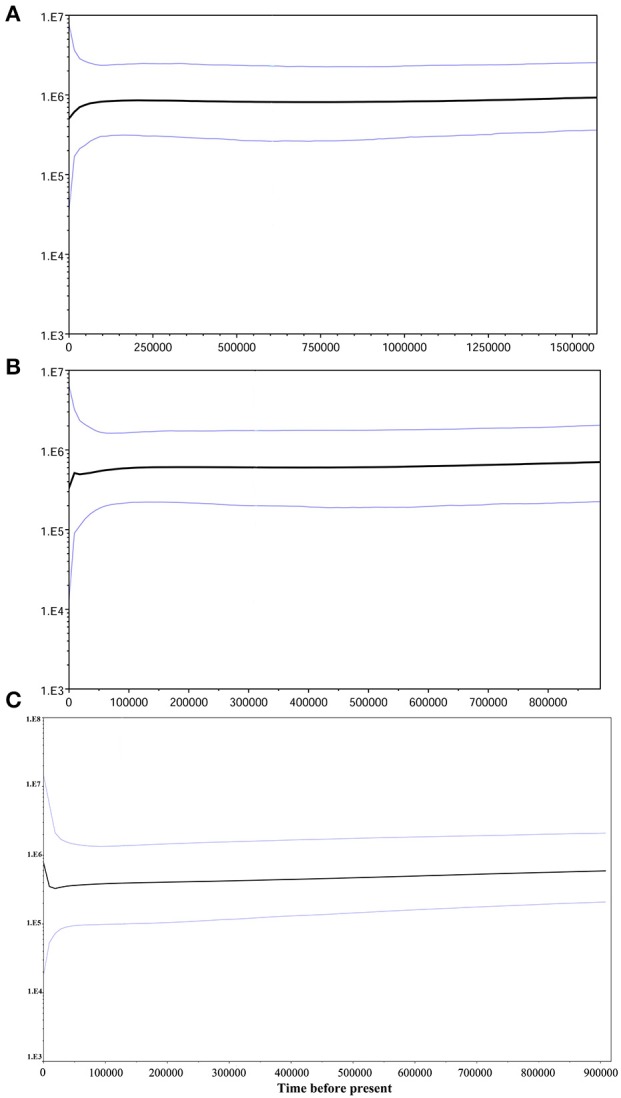
Bayesian skyline plot based on cpDNA (A) and single copy nuclear gene SmHP (B) as well as RPB1 (C) for the effective population size fluctuation throughout time. Root height is set as median of the maximum time. Black line: median estimation; areas between gray lines: 95% confidence interval.